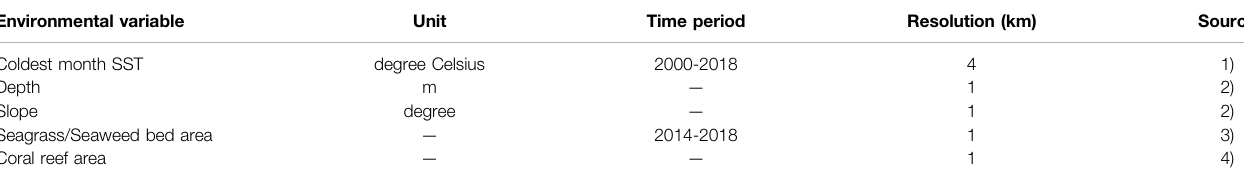
TABLE 2 | Environmental variables used for the species distribution